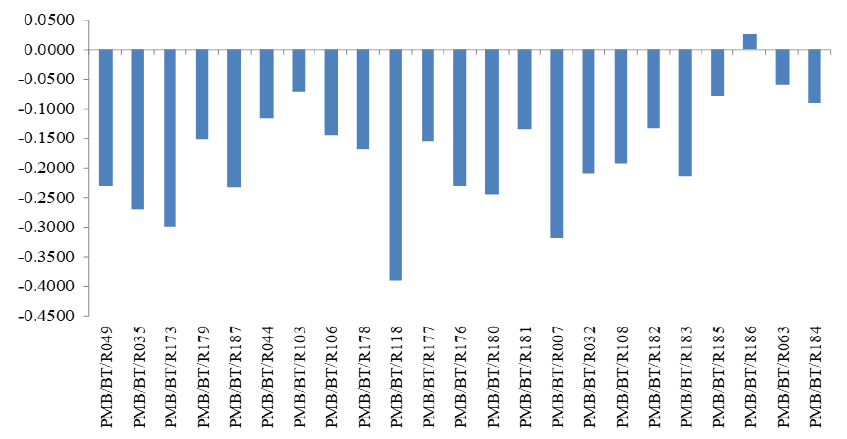
Figure 6 Stress response index of different cultivars under 0.8 mg/L arsenic